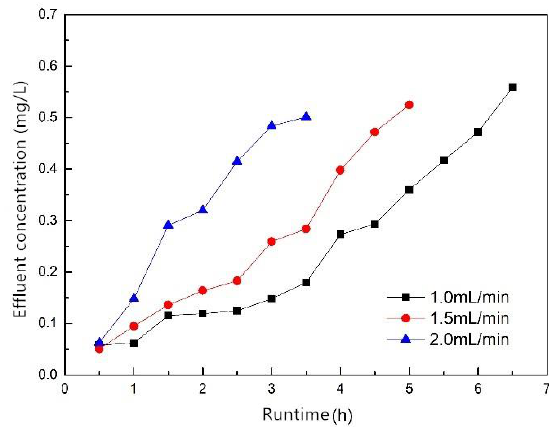
Figure 9. Breakthrough curves of different influent flow rates.